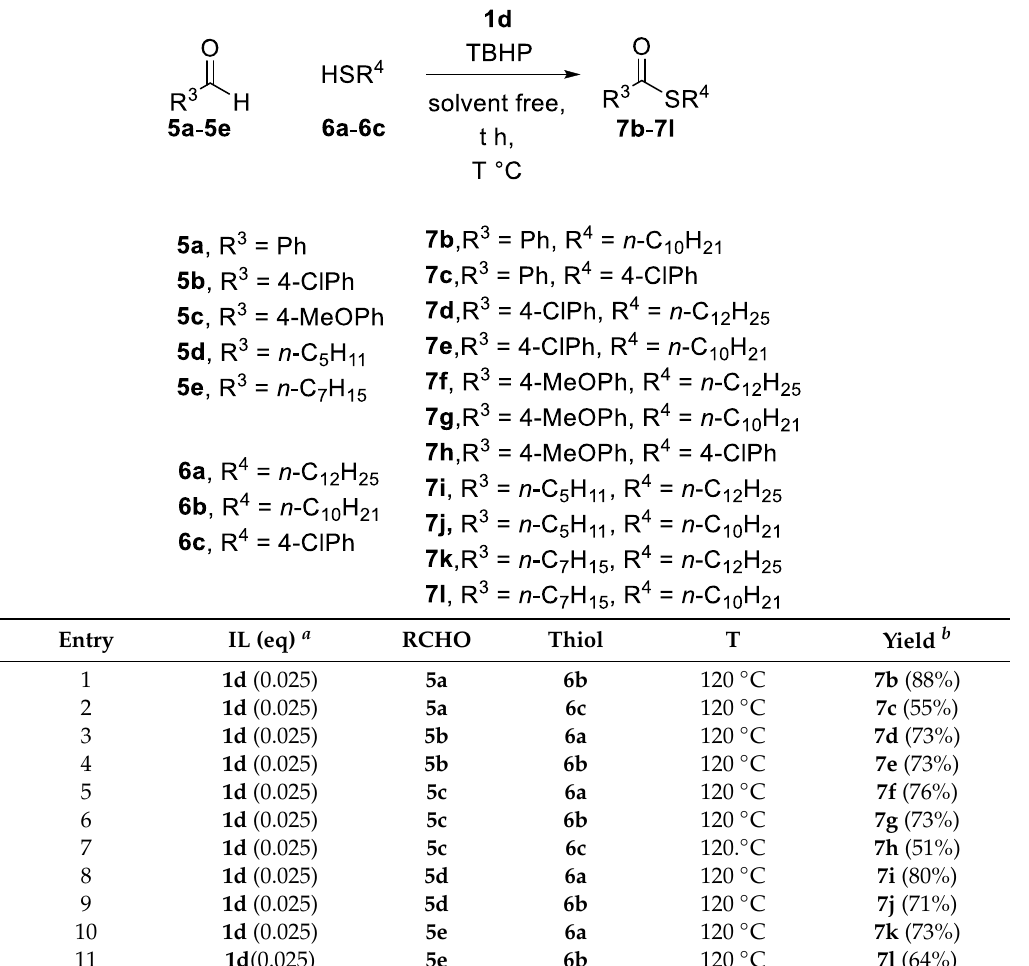
Table 4. Ionic liquids 1d catalyzed coupling reaction with aldehydes 5a – 5e and thiols 6a – 6c without solvent.